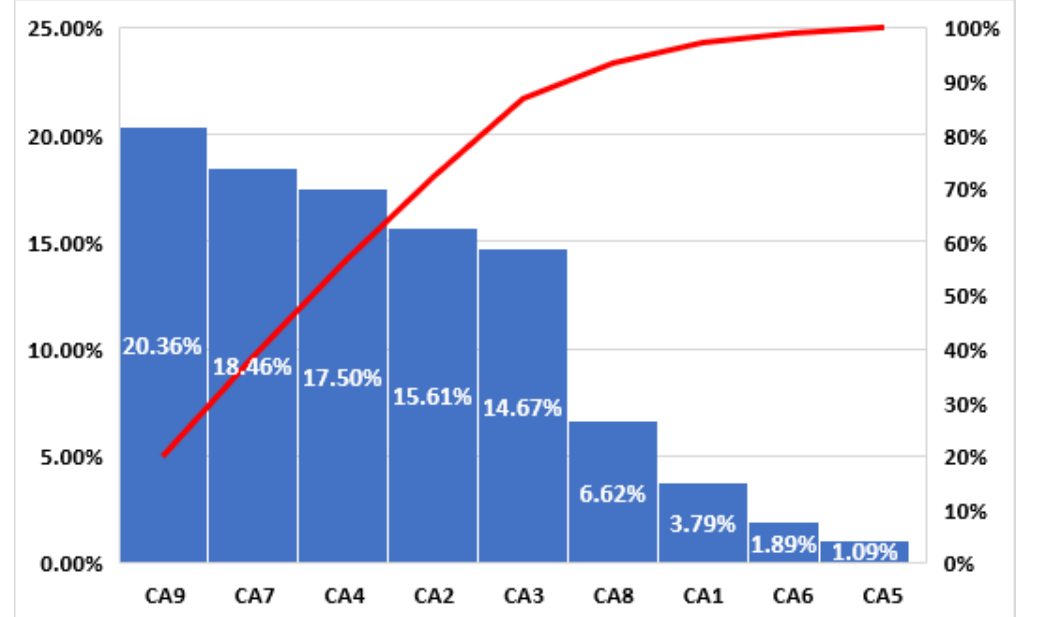
Figure A1. Schools ’ preparedness evaluation presented by Pareto chart. In descending order by bars are represented the assessed nine individual values of causes that reduces the schools’ safety: CA1 = Compiled a map or risk overview; CA2 = Sufficient Funds; CA3 = Safety Staffing; CA4 = Material security; CA5 = Theoretical training; CA6 = Practical training; CA7 = Training organization; CA8 = Integrated Rescue System; CA9 = Identity verification; and the cumulative total is represented by the red line.